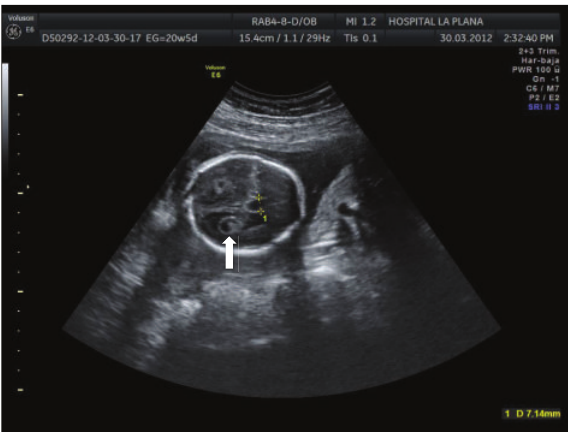
Figure 2: Dilated cavum septi pellucidi (7.14 mm) and bilateral choroid plexus cysts (arrow).